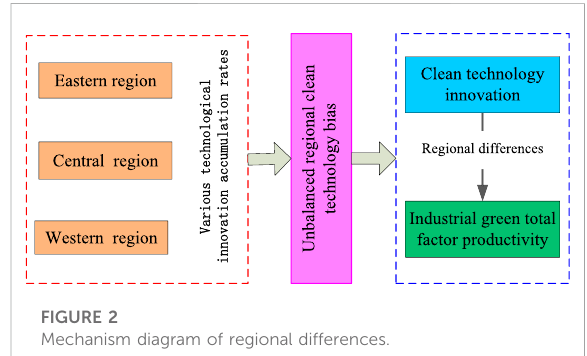
FIGURE 2 Mechanism diagram of regional